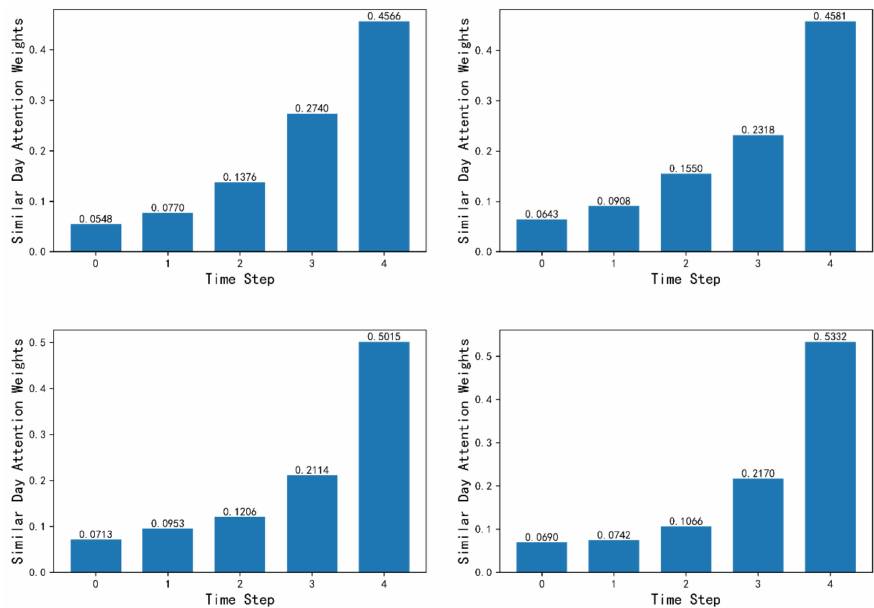
Figure 13. Similar Day Attention